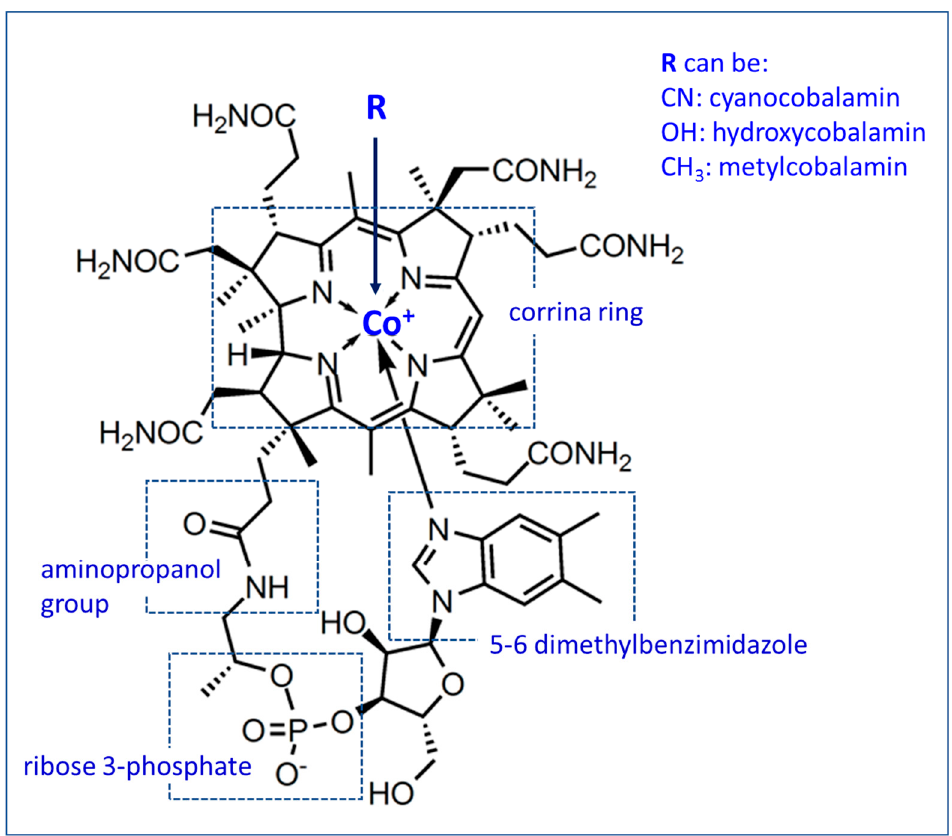
Figure 1. Empirical formula of vitamin B12.